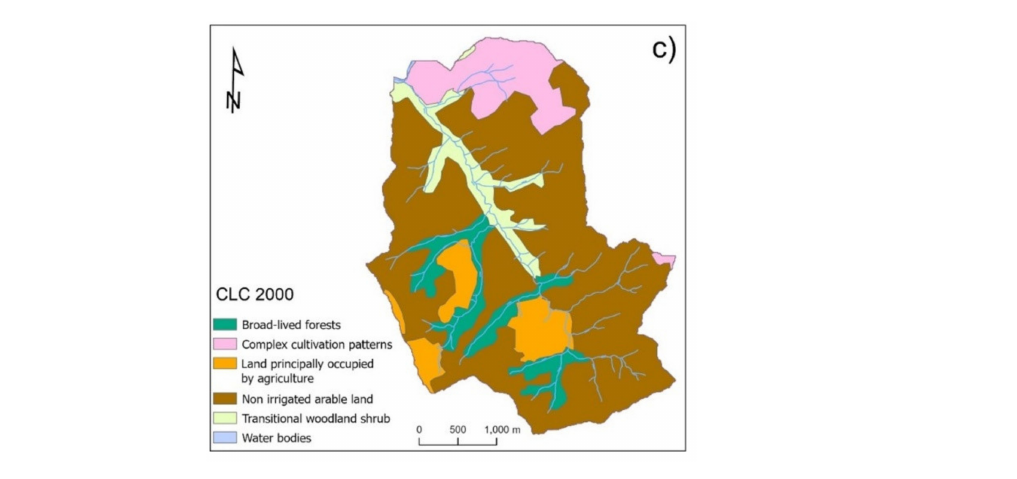
Figure 2. San Rocco basin. ( a ) Schematic geological and geomorphological map; ( b ) land use map based on the CLC classification of 2018; ( c ) land use map based on the CLC classification of